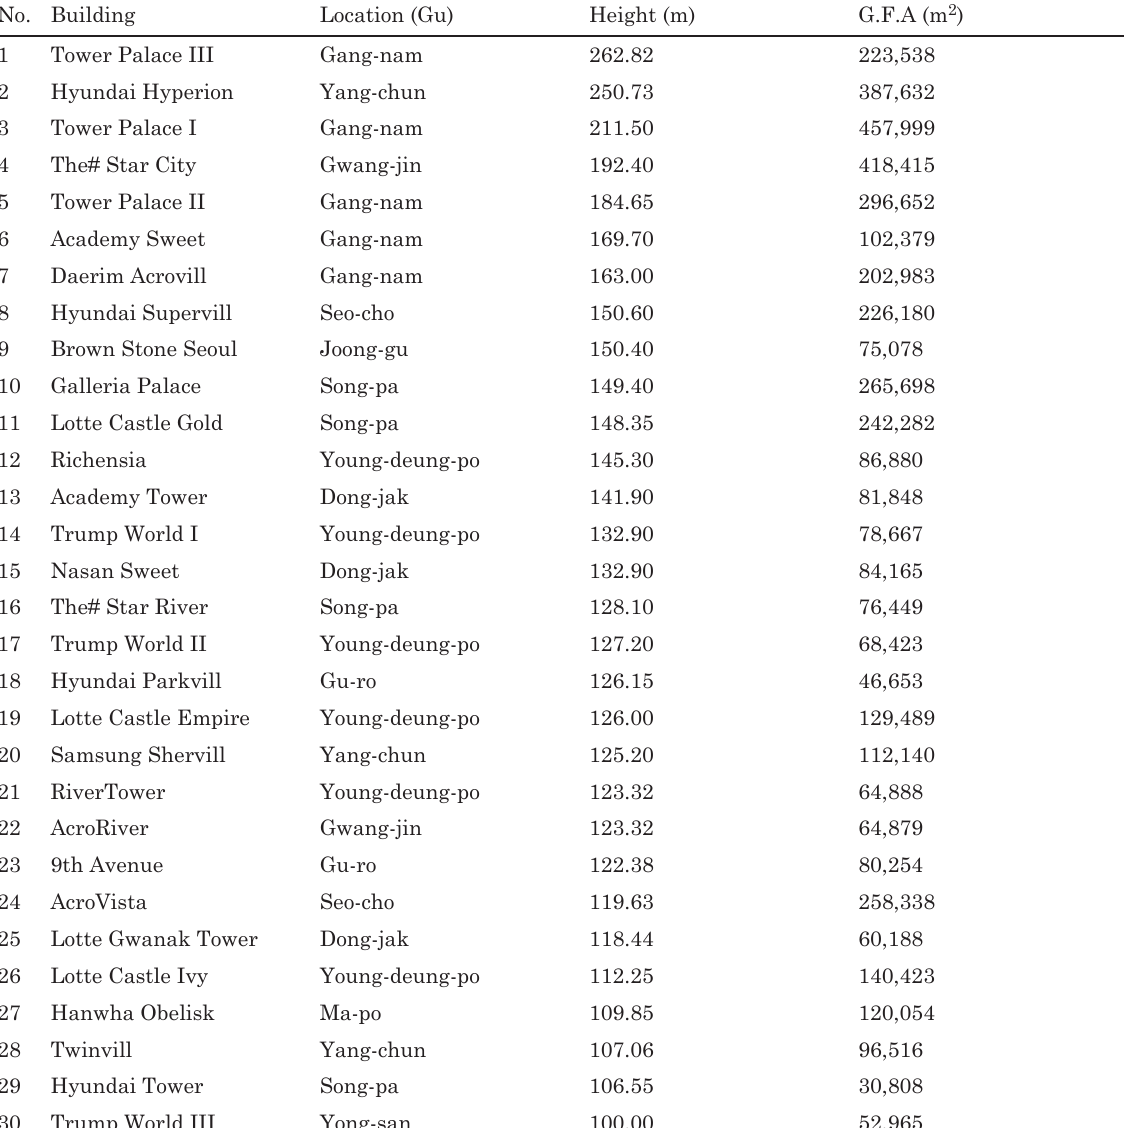
table 5. basic information of the buildings in seoul no.